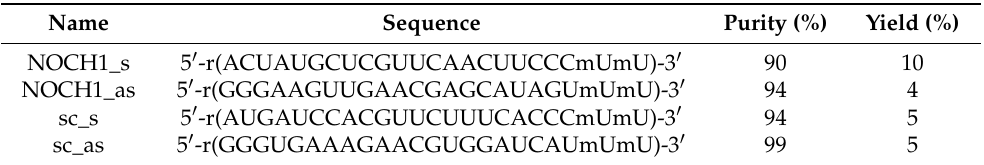
Table 2. Sequences of the single strand RNA used in this study. s (sense), as (anti sense), sc